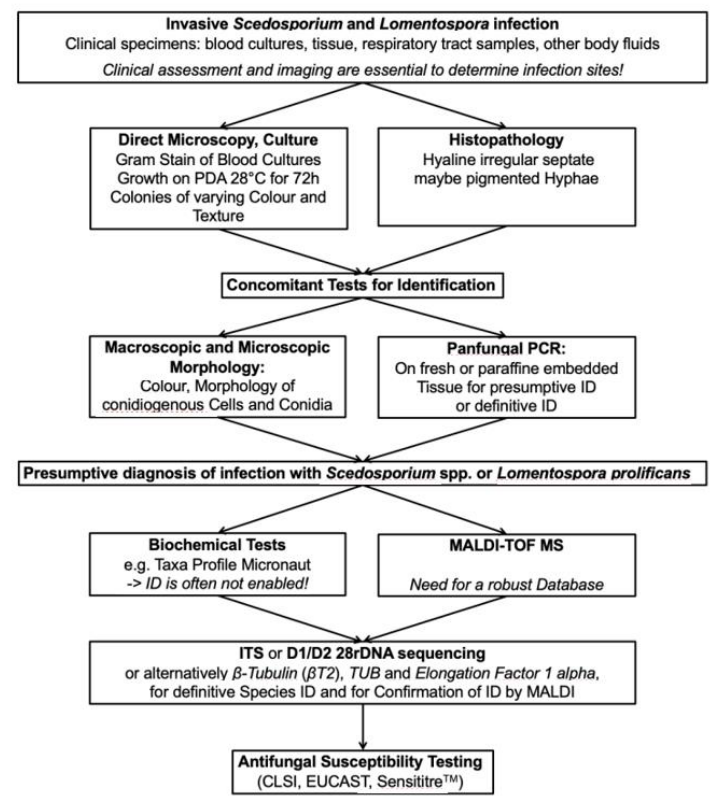
Figure 4. Workflow for diagnosis of invasive Scedosporium and Lomentospora prolificans infections. CLSI = Clinical and Laboratory Standards Institute; EUCAST = European Committee on Antimicrobial Susceptibility Testing; rDNA = ribosomal DNA; ID = identification; ITS = internal transcribed spacer; MALDI-TOF MS = matrix-assisted laser desorption/ionization time-of-flight mass spectrometry; PCR = polymerase chain reaction; PDA = Potato dextrose agar; TUB = Tubulin. Of note, ITS-directed assays may not be able to distinguish between species within the S. apiospermum complex, as no DNA barcoding gap is present, due to the relatively large degree of genetic variation found in this species complex. The use of alternative loci, such as the βT2 gene, TUB and elongation factor 1 alpha genes may be necessary (see Figure 5).